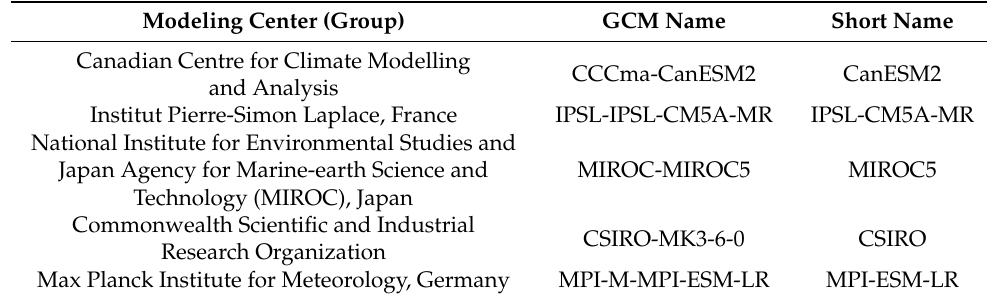
Table 1. Description of the CORDEX-Africa Regional Climate Model (RCA4) simulations.